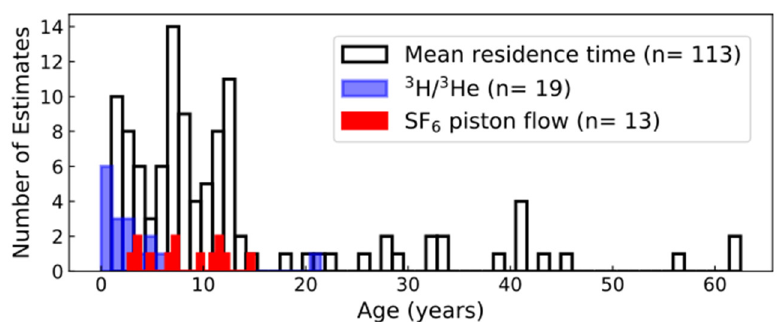
Figure 8. Histogram of estimates of mean residence time from lumped-parameter modeling, 3 H/ 3 He apparent ages, and idealized SF 6 piston-flow ages. Different numbers of analyses are available because multiple age estimates are produced from the program TracerLPM, using the lookup mean ages function (see Reference [53], for method details), and because some model calculations fail for idealized SF 6 piston flow (see Table 2).